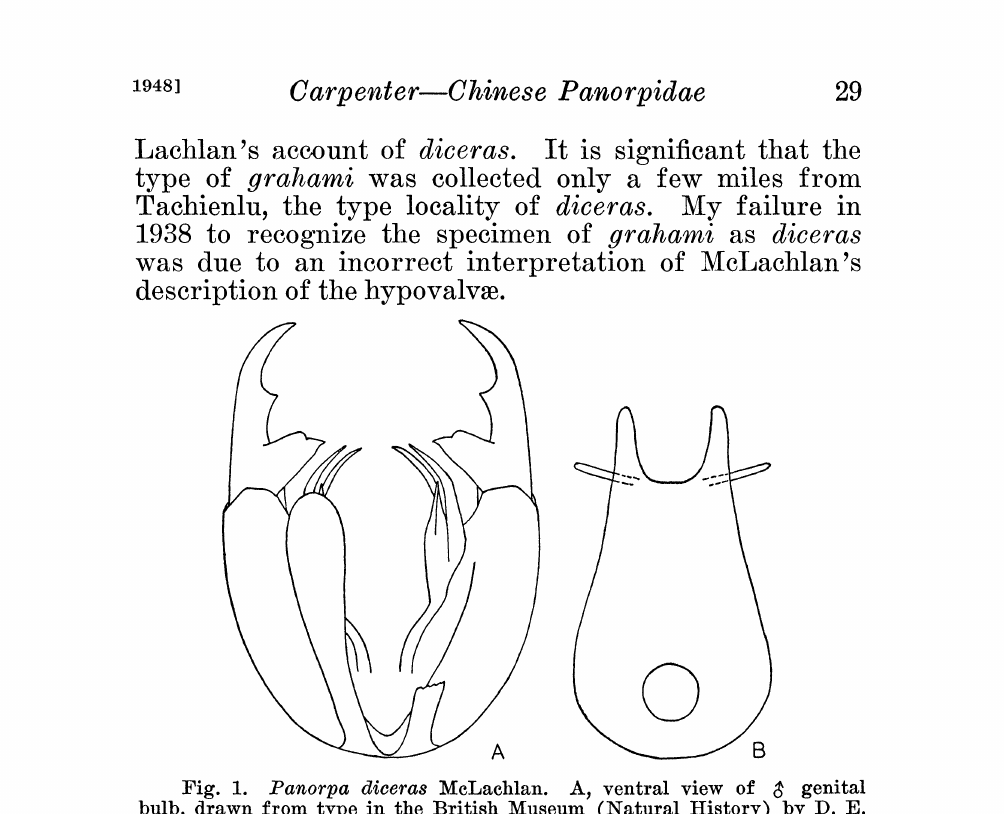
Fig. 1. lanorpa diceras /YlcLachlan. A ventral view of $ genital bulb, drawn from type in the British Museum (Natural History) by D. E. Kimmins. B, prepiproct of same